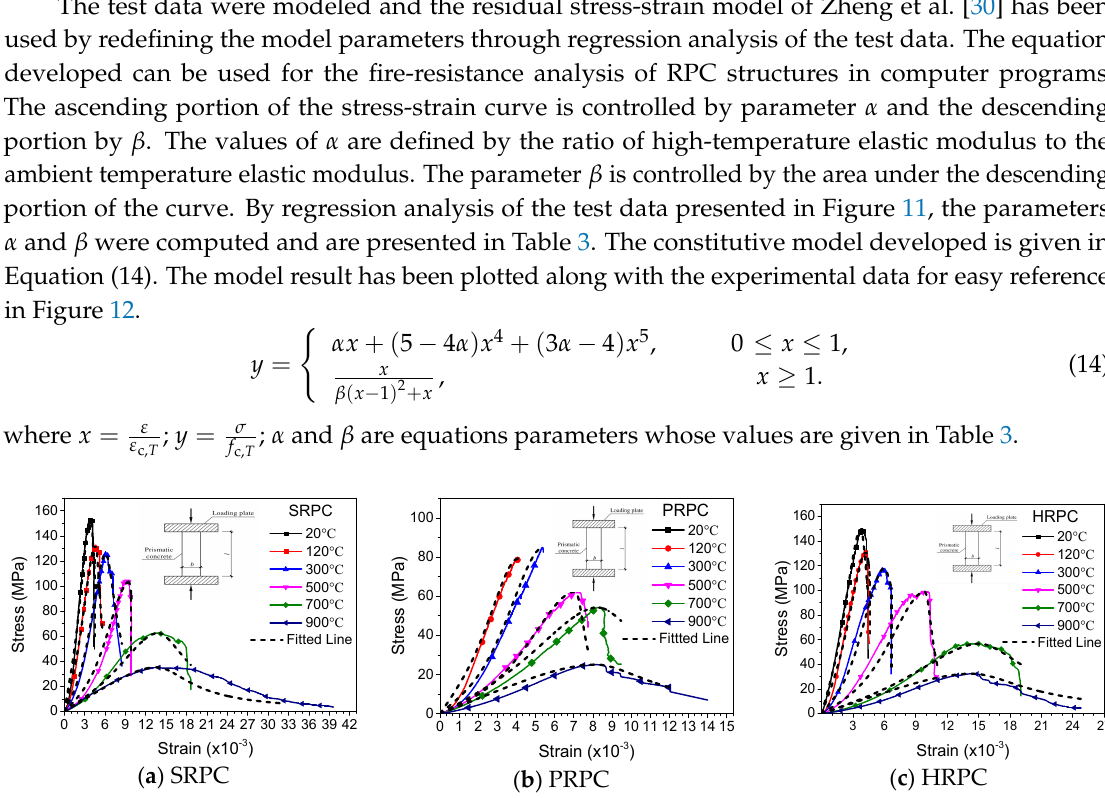
Figure 11. Stress-strain curve of RPC at high temperature.